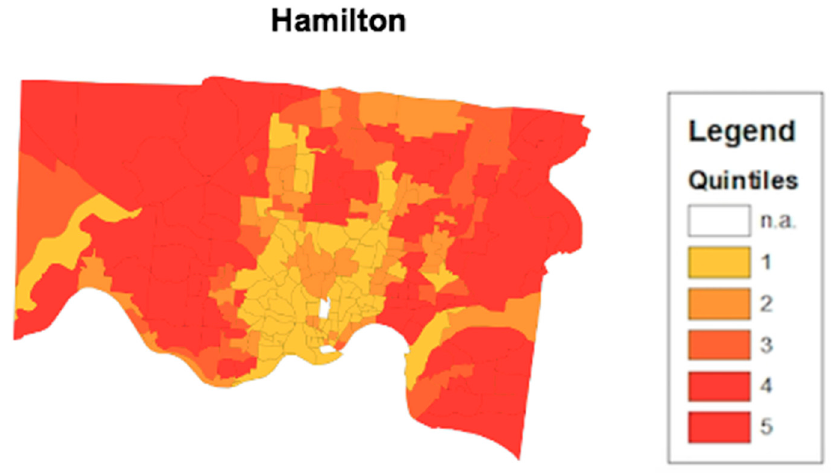
Figure 5. HOI Composite Score map from Hamilton County. The map displays census tracts in Hamilton County in southwest Ohio. The census tracts are color coordinated based on what quintile their HOI composite score falls in. The lower HOI Composite scores fall in the first quintile while the higher HOI scores fall in the fifth quintile.